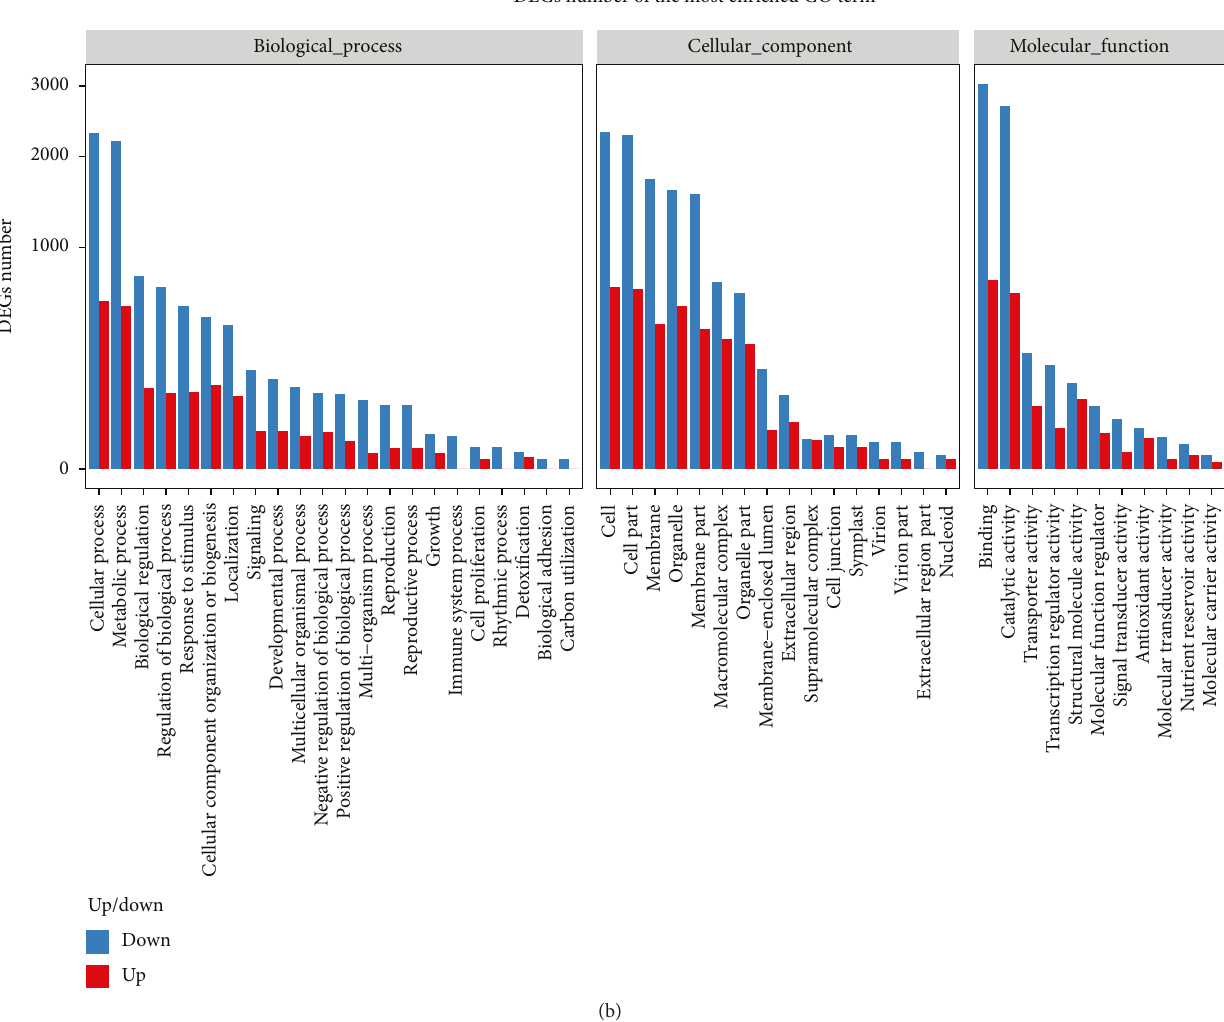
Figure 4: GO analysis of DEGs. (a) GO classi fi cation of DEGs. (b) GO classi fi cation of upregulated and downregulated